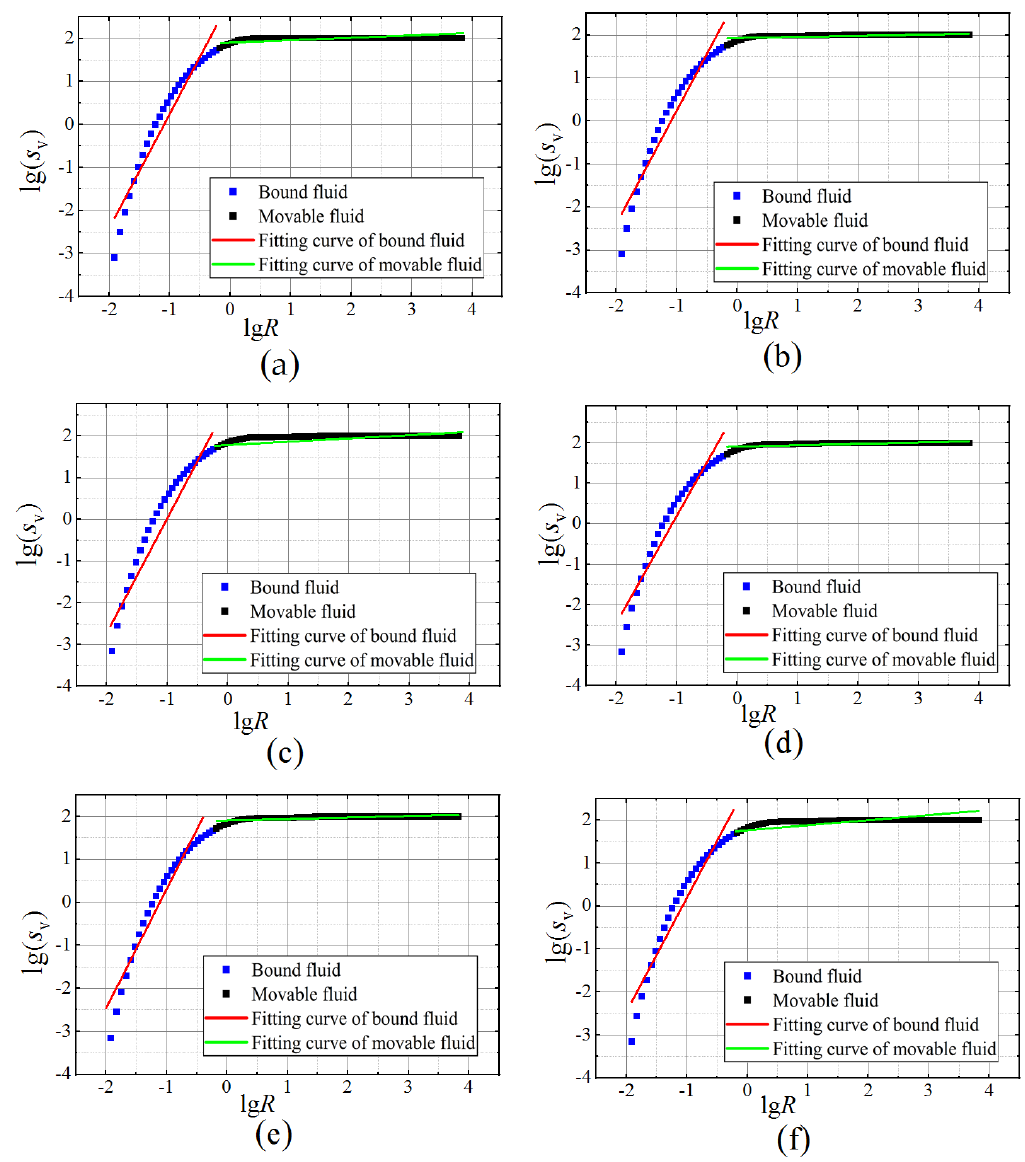
Figure 8. The lg S v-lg R curves under various freezing durations: ( a – f ) represent 1 h, 2 h, 4 h, 6 h, 12 h and 18 h, respectively.